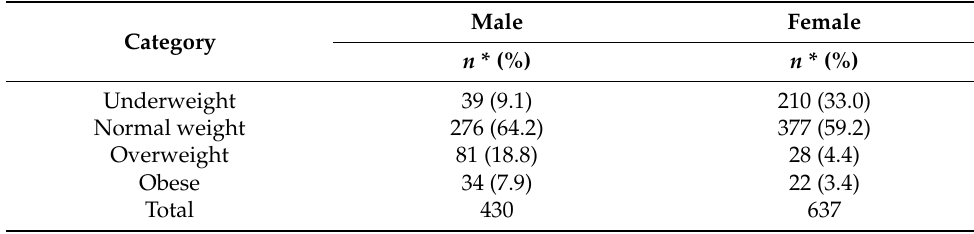
Table 1. Distribution of respondents’ BMI